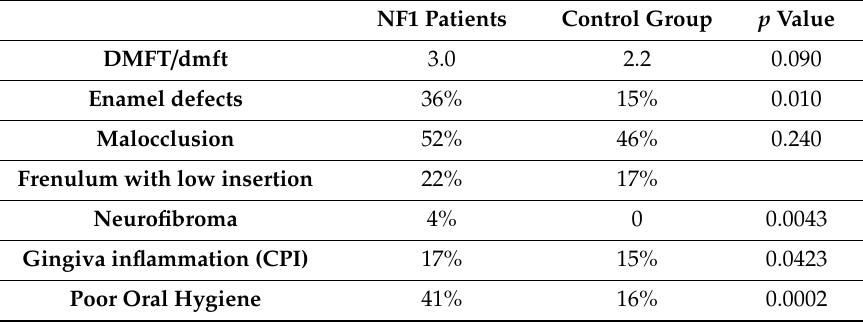
Table 3. Statistical comparisons between the oral conditions investigated in the two groups analyzed.